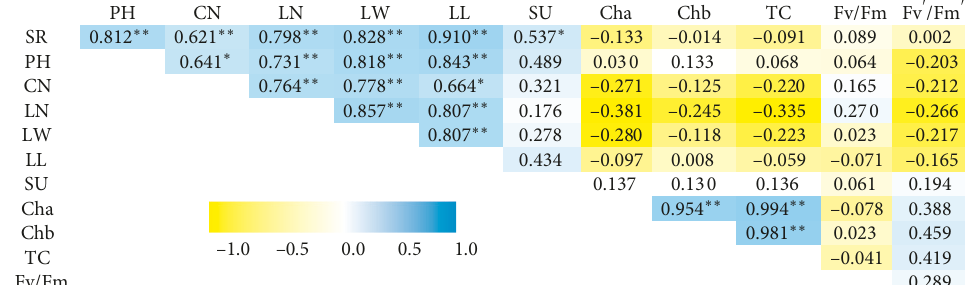
Figure 6: Heat maps explaining the phenotypic correlation coefficient estimation of growth and physiological characteristics in Luem Pua rice after NaCl treatment for four